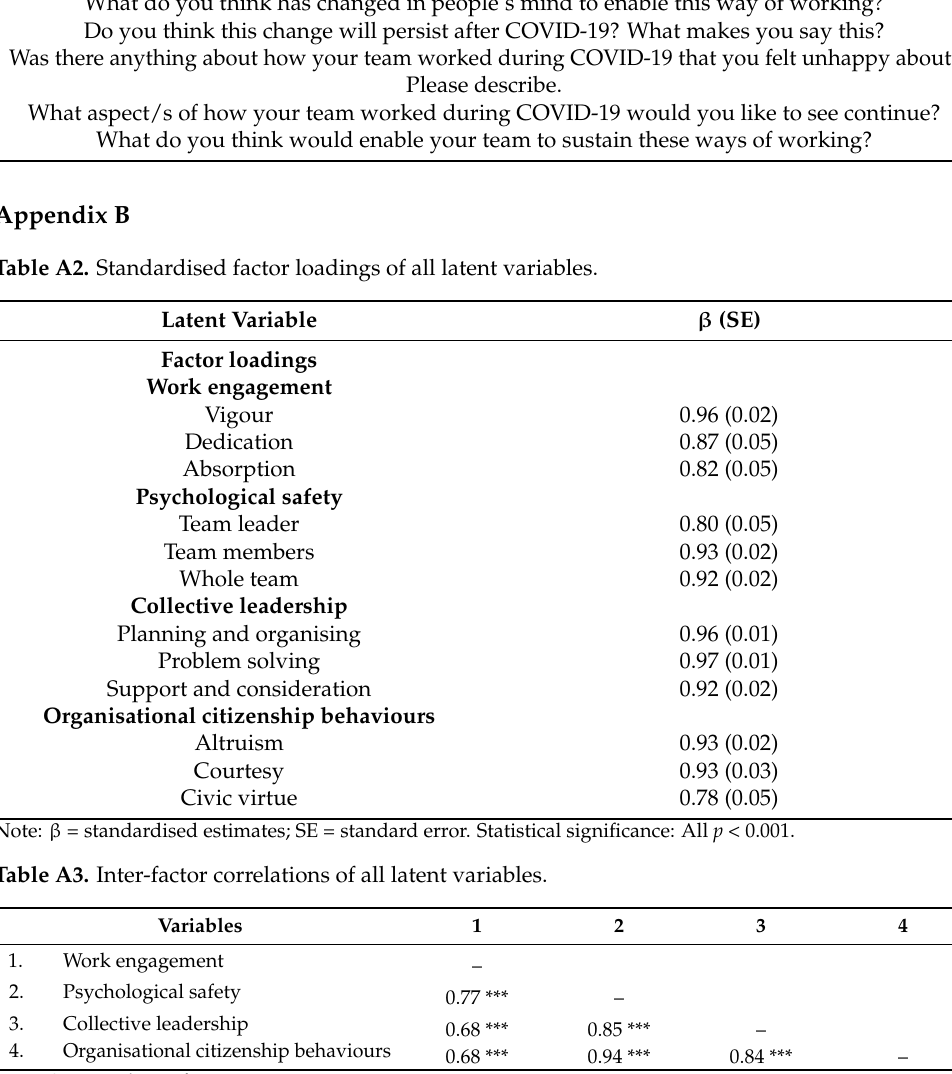
Table A1. Open-Ended Questions. The following questions intend to capture attitudes towards, and motivations driving, new ways of working during COVID-19. What, if any, is the most significant change you’ve observed in how your healthcare colleagues are working during the COVID-19 response?